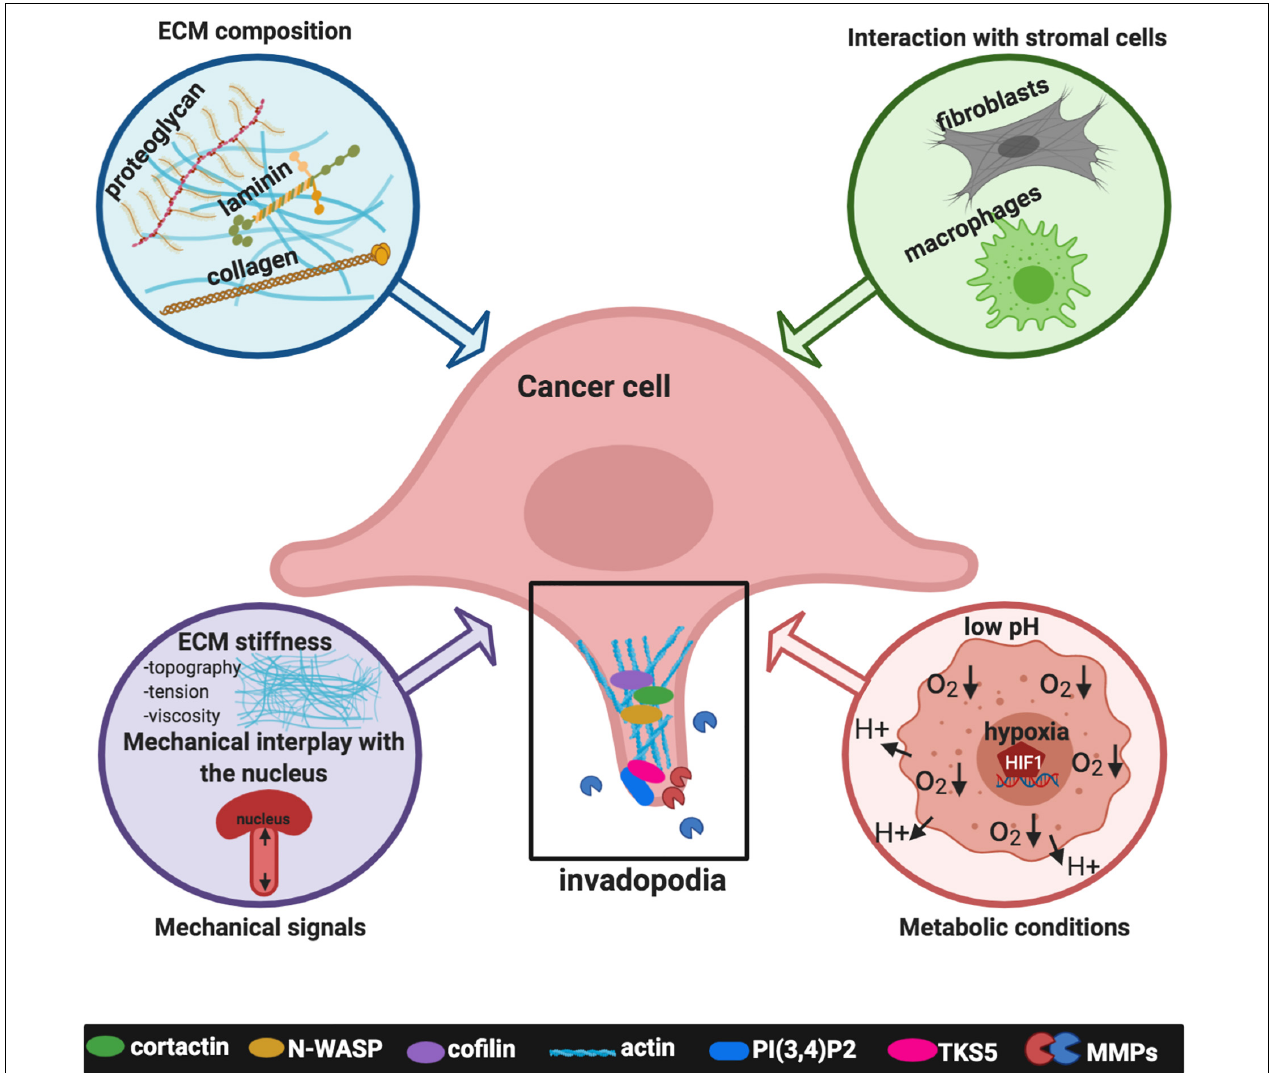
FIGURE 2 | Signals deriving from the tumor microenvironment (TME) affecting invadopodia formation and activity. Inputs derived from the TME include the extracellular matrix (ECM) composition, such as collagens, laminin, fibronectin; the interaction with stromal cells, specifically activated fibroblasts, and macrophages; mechanical signals such as matrix stiffness, topography, tension, viscosity and the mechanical interplay with the nucleus; metabolic conditions typical of cancer cells, such as extracellular acidosis and intracellular low tensions oxygen (hypoxia). The plot was created using BioRender